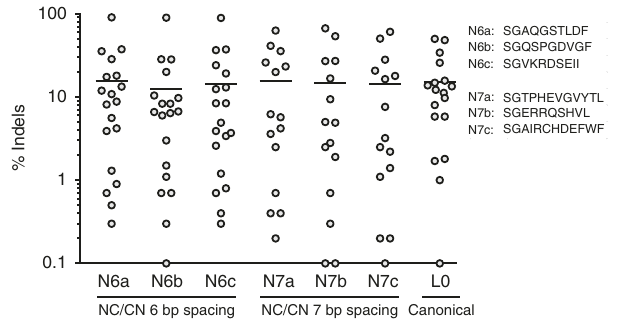
Fig. 3 Activity comparison of NC/CN architectures with canonical ZFNs. The NC/CN ZFN architectures were tested in a portability study for their editing ef fi ciency in the context of diverse new ZFN designs. Two sets of 19 NC/CN ZFNs were designed against an endogenous locus (intron 1 of the gene bearing the AAVS1 safe harbor ), one set with a 6 bp spacing, and one with a 7 bp spacing. DNA encoding the top three linkers for their respective spacings (identi fi ed in the stage 3 screen, Supplementary Fig. 7) was cloned into an expression vector between the ZFP and FokI domains for each of the designs bearing an amino-terminal FokI cleavage domain. Plasmid DNA for each pair was nucleofected into K562 cells at a dose of 400ng of DNA per ZFN. Genomic DNA was isolated after three days of incubation and modi fi cation was assessed by PCR of the target loci followed by deep sequencing (MiSeq). The results of this study are grouped by architecture type and by linker: NC/CN ZFNs spanning a 6 bp gap with the indicated linker (N6a-N6c), NC/CN ZFNs spanning a 7 bp gap with the indicated linker (N7a-N7c), and canonical ZFNs (L0 62 , included for comparison). Linker sequences are shown at the right. Average values for each group are shown as a solid black bar. Each data point represents a single measurement. For plotted data values see Supplementary Fig. 8. The source data for this fi gure is available in the Source Data fi